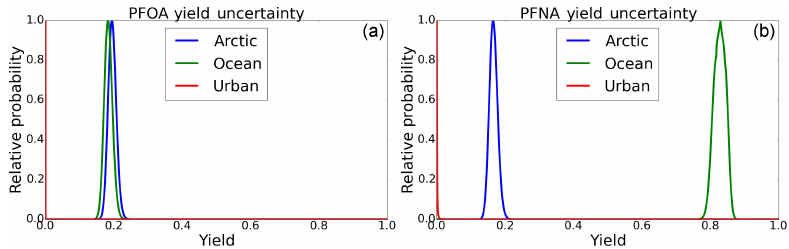
Figure 3. Uncertainty distributions of PFOA (a) and PFNA (b) yields for urban, ocean, and Arctic conditions. In both cases, urban yields are much less than